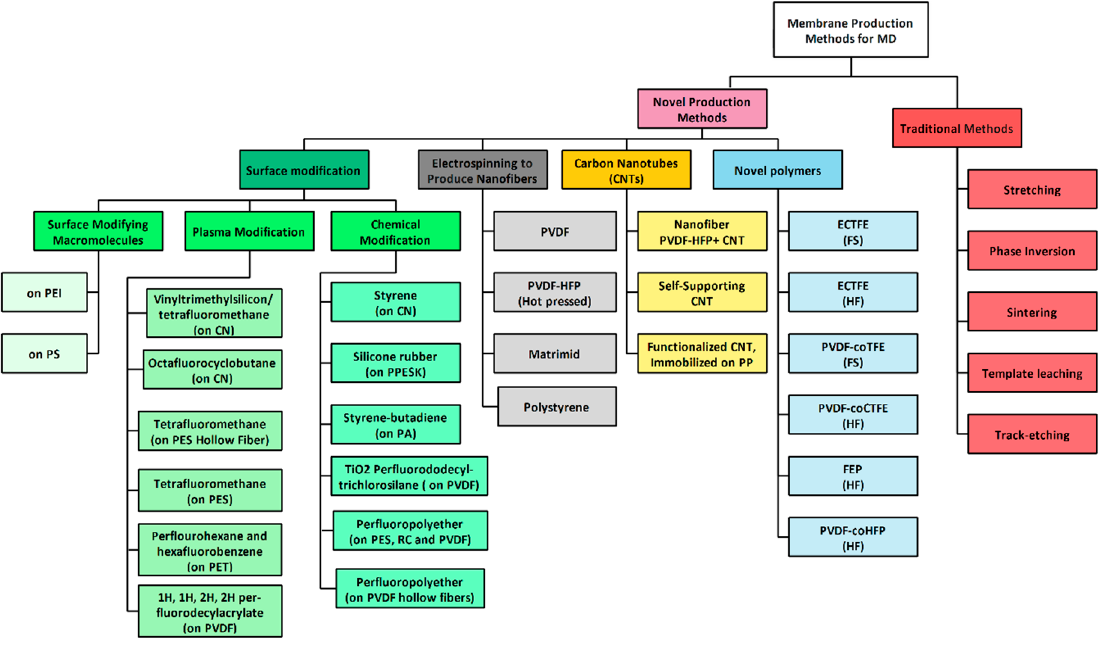
Figure 11. Schematic diagram of various methods for membrane production applied in MD technology [163] .